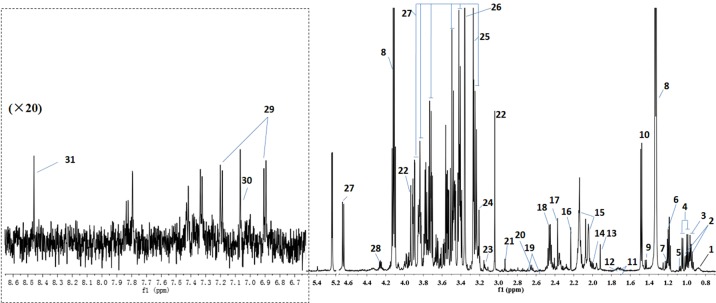
Shows representative 1H-NMR spectra with peak assignments for serum sample from SHR-N group. 1. VLDL/LDL, 2. Isoleucine, 3. Leucine, 4. Valine, 5. Isobutyrate, 6. 3-Hydroxybutyrate, 7. 3-Aminoisobutyrate, 8. Lactate, 9. Lysine, 10. Alanine, 11. Arginine, 12. Lysine, 13. Acetate, 14. Proline, 15. N-acetylated glycoprotein (NAC), 16. Acetone, 17. Pyruvate, 18.Glutamine, 19. Citrate, 20. Methionine, 21. N,N-Dimethylglycine, 22. Creatine, 23.Methylristidine, 24. Choline, 25. Betaine, 26. Methanol, 27. Glucose, 28. Threonine, 29. Tyrosine, 30. Methylistidine, 31. Formate.